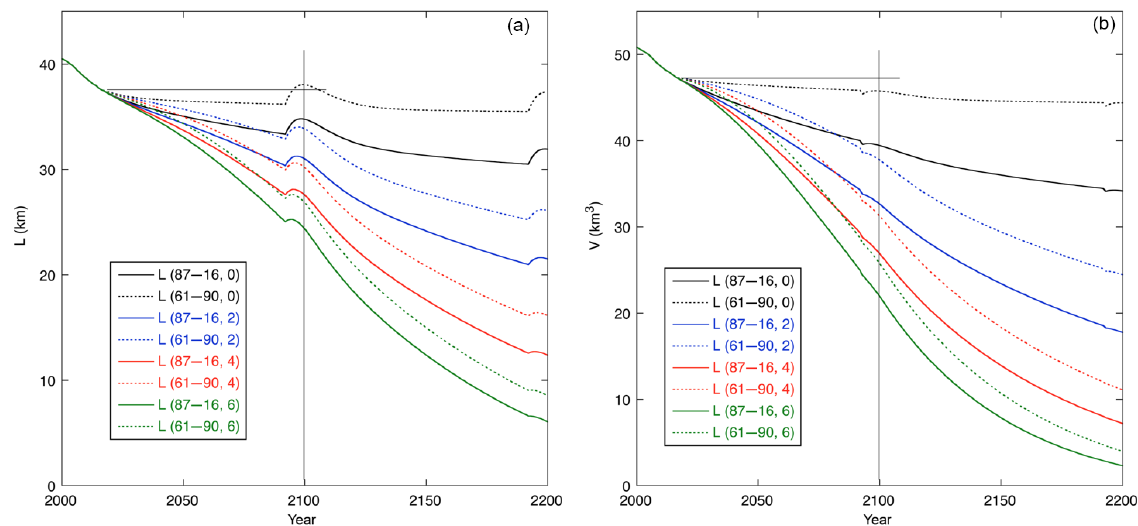
Figure 10. Projections of glacier length (a) and volume (b) for different climate change scenarios. The labels refer to the ELA reference period (either 1961–1990 or 1987–2016) and the rise of the ELA per year during the 21st century (in ma − 1 ) .